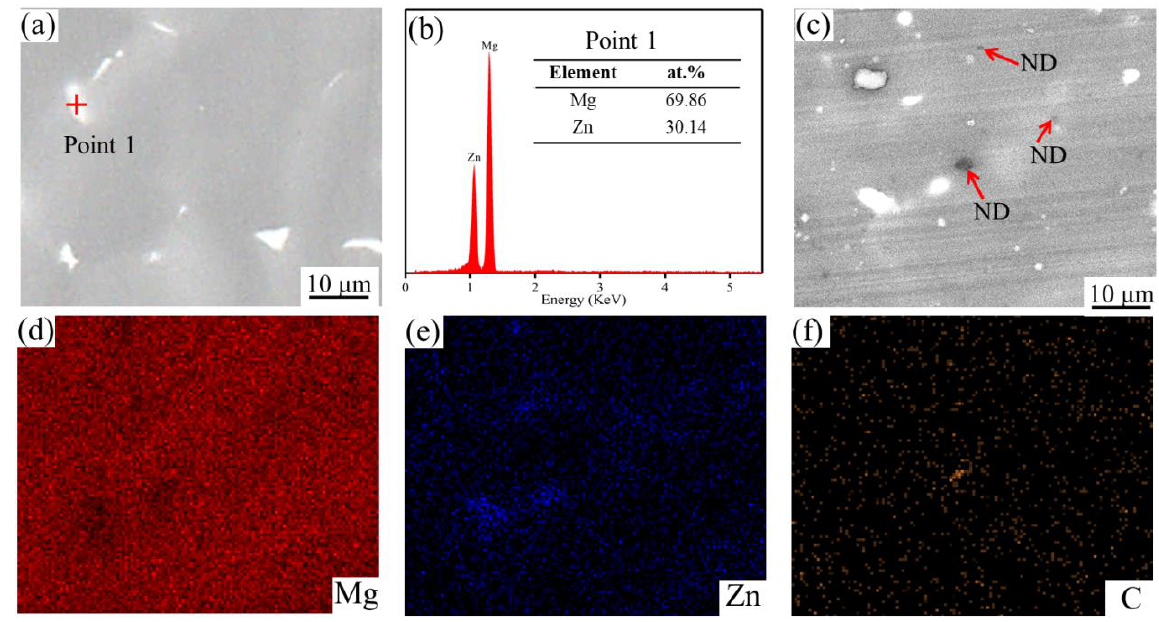
Figure 4. ( a ) SEM image of SLMed ZK60 and ( b ) corresponding EDS of point 1; ( c ) SEM image of SLMed ZK60−6ND and its corresponding EDS map of ( d ) Mg, ( e ) Zn, and ( f ) C element.